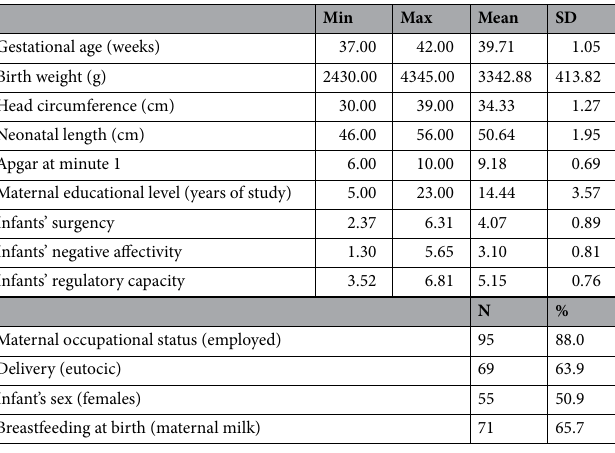
Table 1. Descriptive